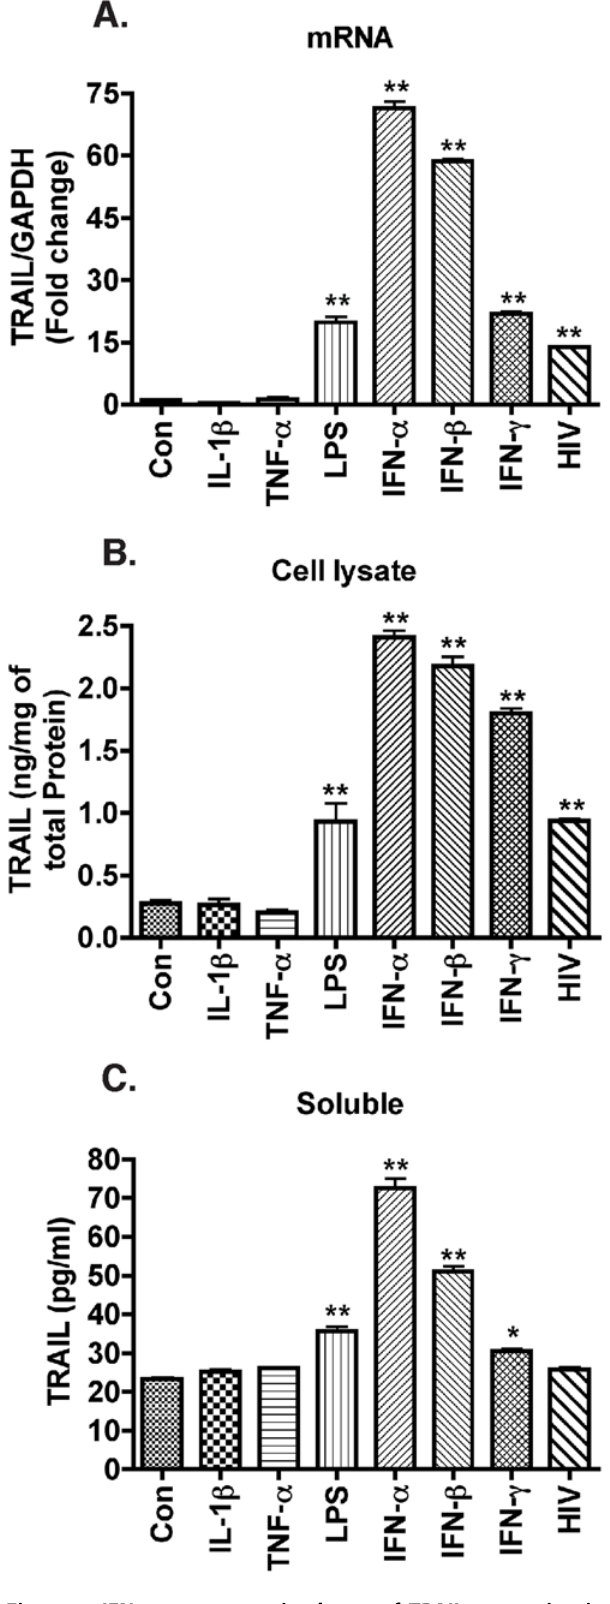
Figure 5. IFNs are potent stimulators of TRAIL expression in macrophages. Human MDM were infected with HIV-1 or stimulated with different inflammatory cytokines IL-1 b (50 ng/ml), TNF- a (100